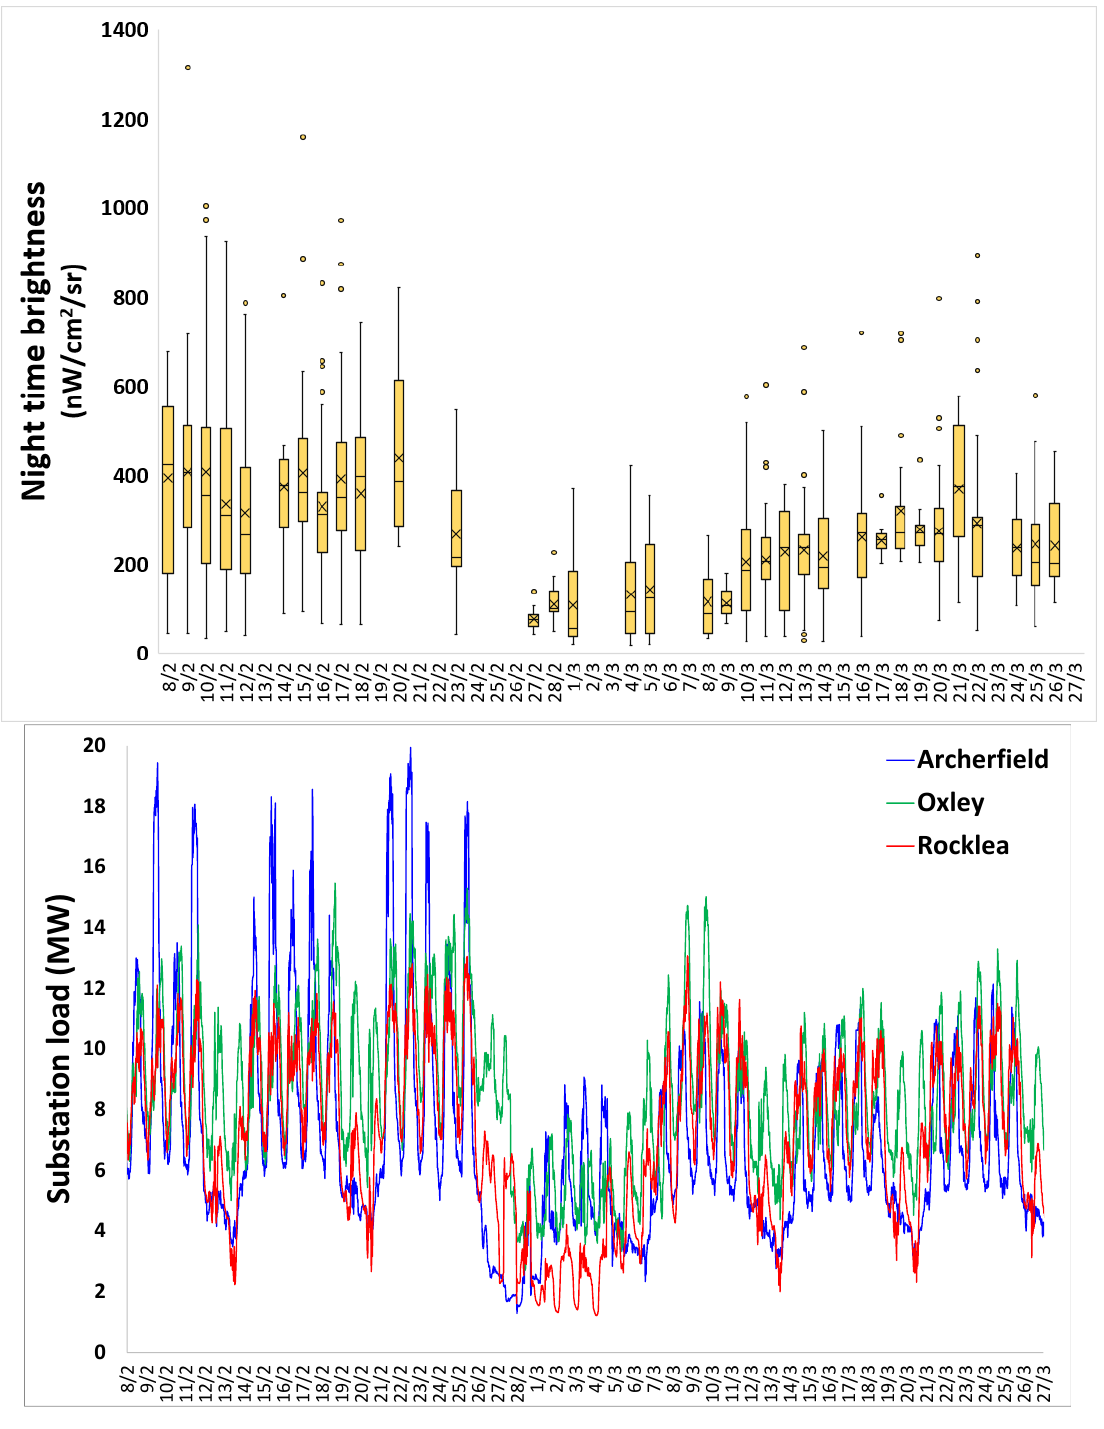
Figure 10. Top: Box plot of nighttime brightness for 40 VIIRS grid cells in the Oxley Creek floodplain where there was a statistically significant difference in nighttime brightness between period 1 and period 2. Bottom: Substation electricity loads (half-hourly data from Energex) for three substation zones corresponding with the Oxley Creek floodplain. The boxplot only includes cloud-free data.